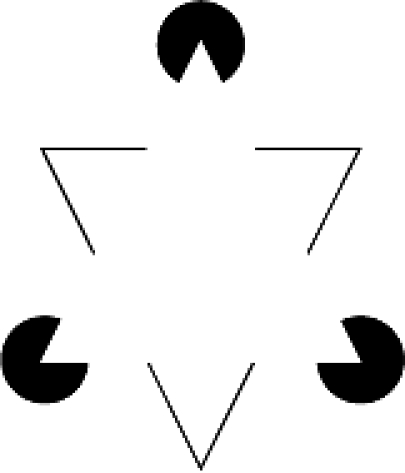
The Kanizsa TriangleAnimals do experience the illusion, although some species may be more inclined to attend to details, of the pacman before extracting the overall triangular shape (see text).